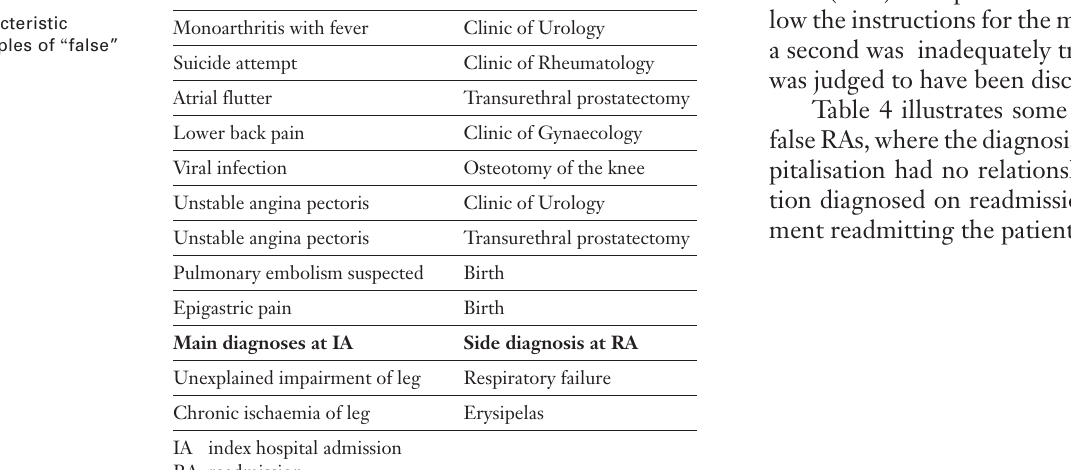
Characteristic examples of “ false”